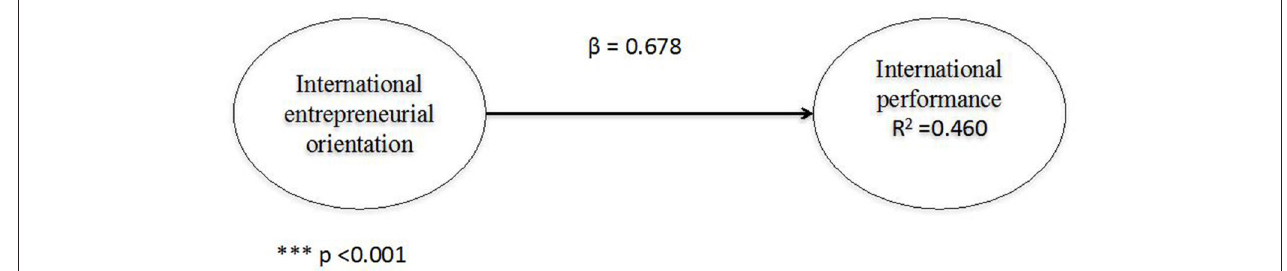
FIGURE 3 | Direct model.